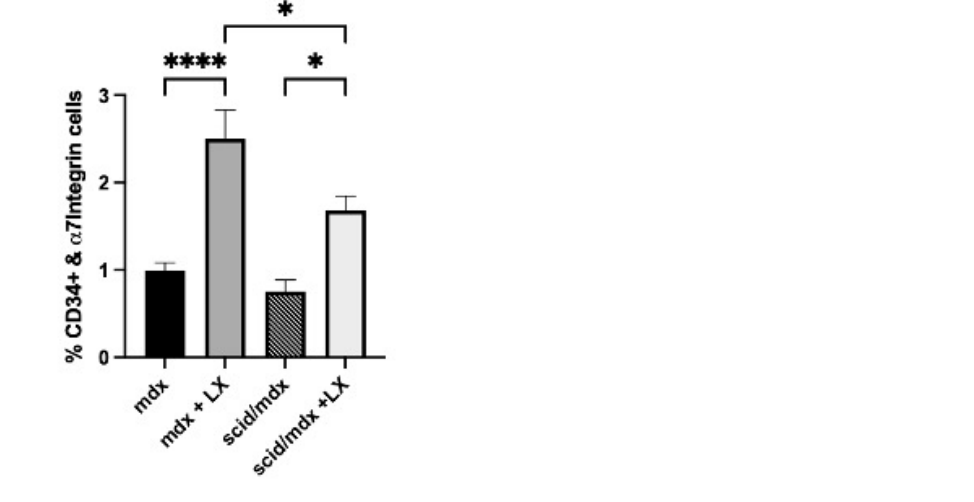
Figure 9. Perinatal LX2931 treatment results in satellite cell expansion in SCID/mdx mice. Female SCID/mdx and mdx mice were treated with LX2931 using the perinatal treatment scheme. Pups were euthanized at three weeks of age, and SCs were quantified in gastrocnemius skeletal muscle by flow cytometry as in Figure 6A. Although the absolute number of SCs was significantly lower in LX2931-treated SCID/mdx compared to LX2931-treated mdx mice, the fold elevation was similar in both strains (2.5-fold in mdx and 2.2-fold in SCID/mdx). * p < 0.05, **** p < 0.001, n = 4–5/group.